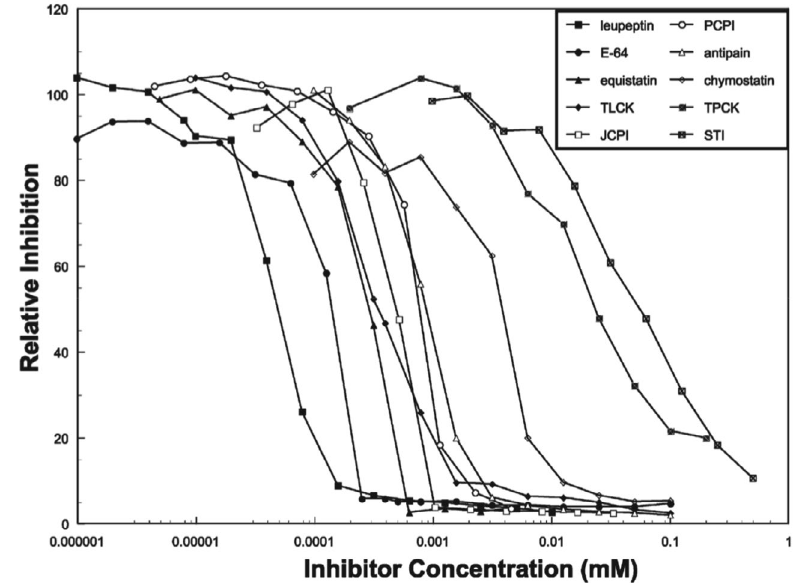
Figure 1. Relative inhibition (as a percent of the control activity) of casein hydrolysis by Tribolium castaneum larval gut proteinases with selected proteinase inhibitors 15 including E-64: L-trans-epoxysuccinylleucylamido w4-guanidinox butane; JCPI, Job’s tears cysteine proteinase inhibitor; TLCK, tosyl-L-lysine chloromethyl ketone; TPCK, N -tosyl-L-phenylalanine chloromethyl ketone; PCPI, potato cysteine proteinase inhibitor and STI, soybean trypsin inhibitor (Kunitz). Leupeptin, E-64, equistatin and TLCK were the most potent caseinolytic enzyme inhibitors. In feeding bio- assays, equistatin and PCPI were the most potent peptides in inhibiting larval growth of the red flour beetle.